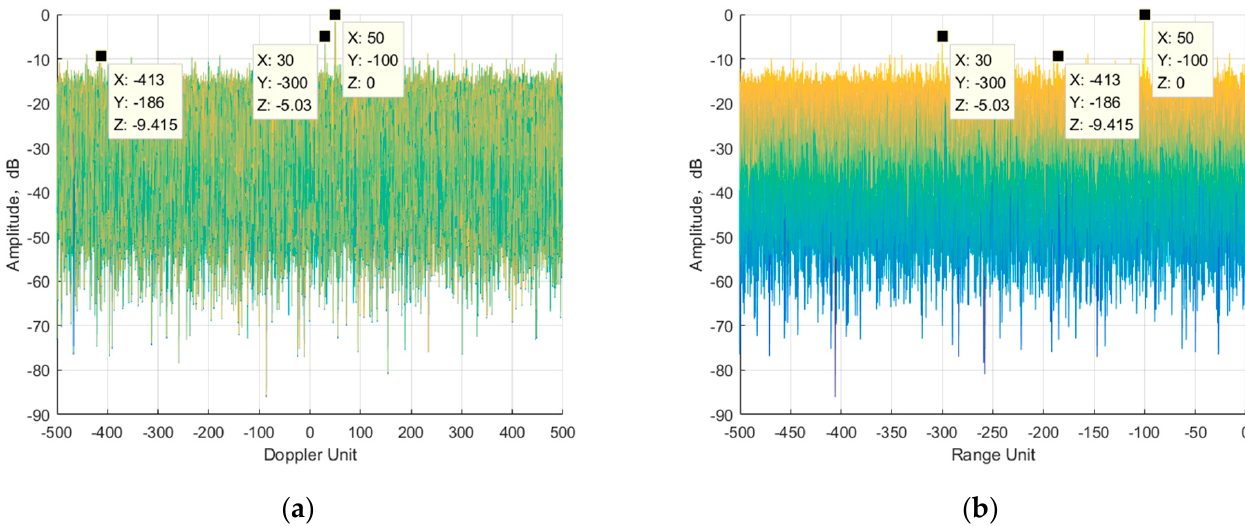
Figure 3. Integration results with the proposed method: N = 10 4 ( a ) Doppler dimension; ( b ) Range dimension.